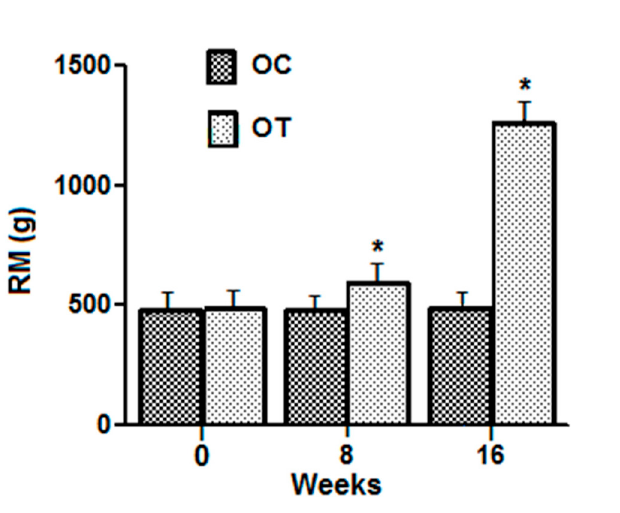
Figure 2. Values for 1 repetition maximum (RM) test. Results are mean ± SEM.*p < .05, compared with the previous test. Groups were compared using one way